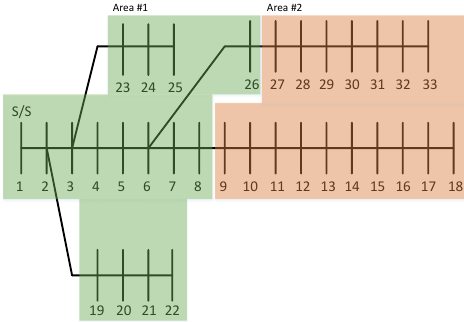
Figure 12. 33 bus system divided in two areas.